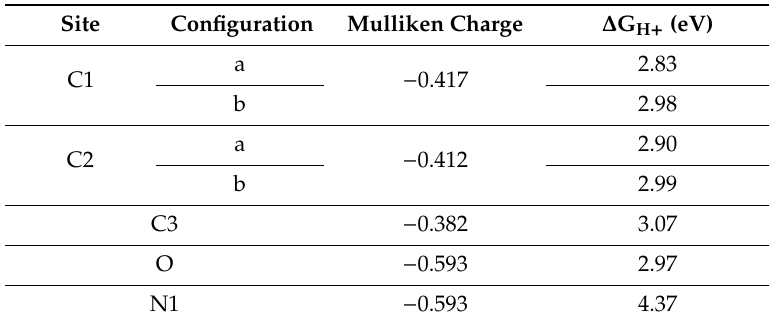
Figure 5. Molecular orbital diagram of the binding of a proton to PCzPO • - . Table 3. Mulliken charge analysis and H + binding free energy ( ∆ G H + ) of di ff erent binding sites and configurations on PCZPO • - moiety, computed by DFT.